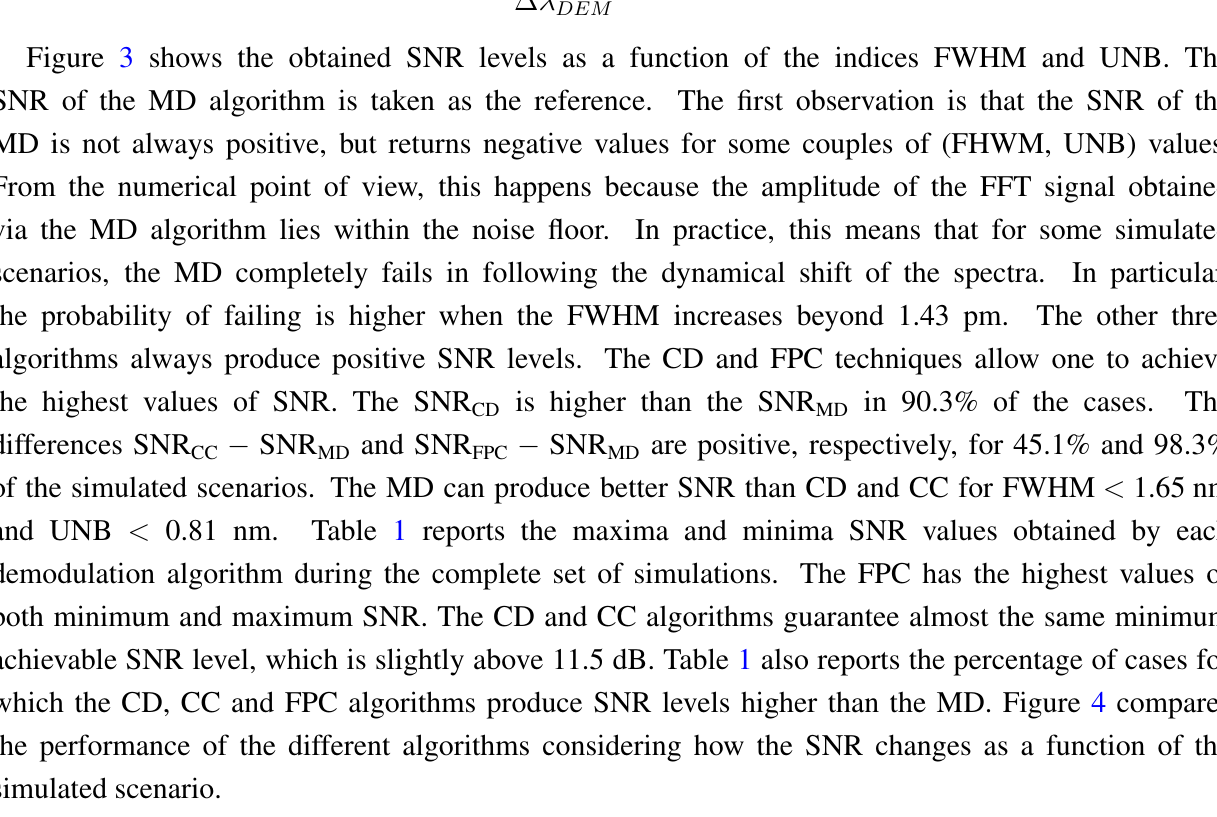
Figure 3. Performance evaluation of the demodulation algorithms in terms of SNR. The maximum detection (MD) algorithm is taken as reference ( upper-right , bottom ).